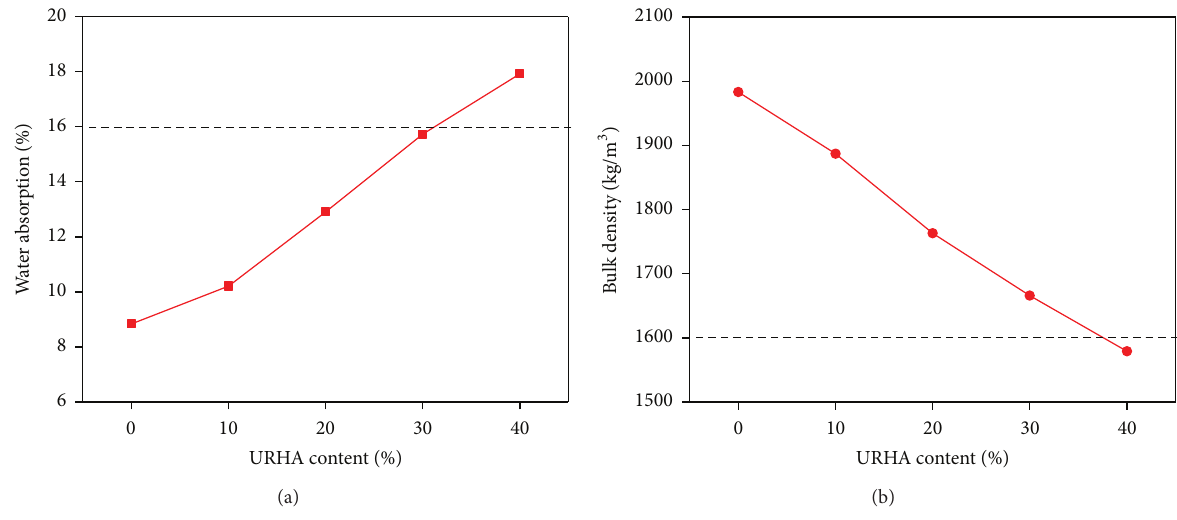
Figure 6: Effect of URHA content on the (a) water absorption and (b) bulk density of bricks.